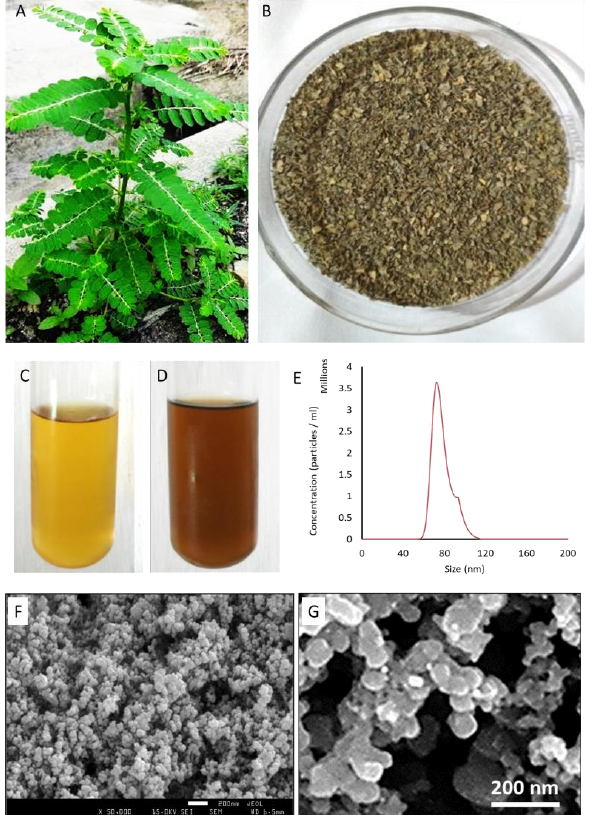
Figure 1. Biosynthesis of GS-AgNP-LEPN. A representative color photograph of ( A ) P. niruri plant; ( B ) powdered leaves of P. niruri ; ( C ) mixture containing leaf extract of P. niruri and 1 mM AgNO 3 in the proportion of 1:3; ( D ) GS-AgNP-LEPN solution after 24 h. Representative ( E ) size distribution by NTA and ( F ) morphology by SEM (Scale bar: 200 nm) of GS-AgNP-LEPN and ( G ) their SEM image at high resolution.